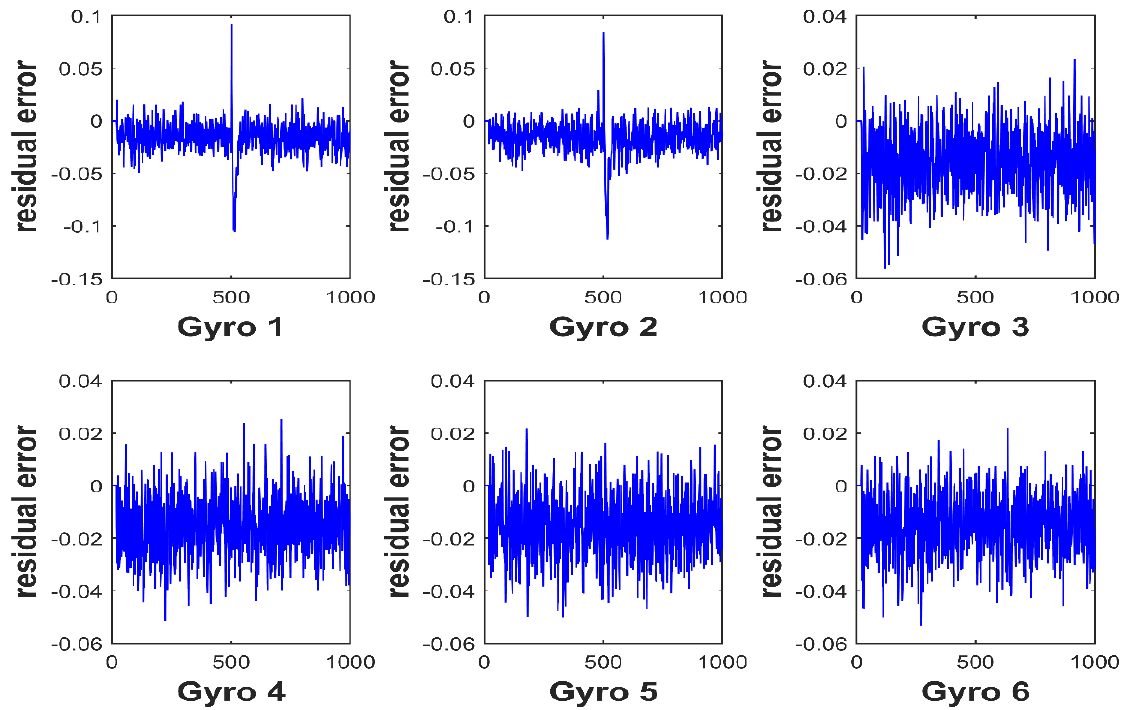
Figure 8. Residual curve for double faults.